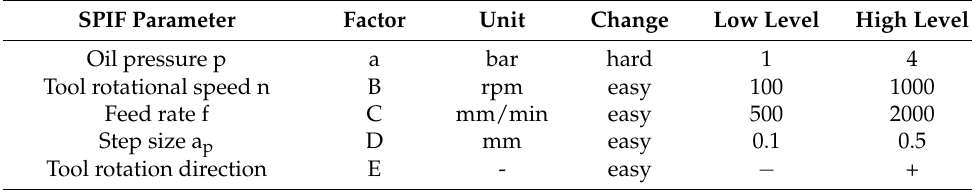
Table 2. Factors and levels used in the split-plot I-optimal design *.